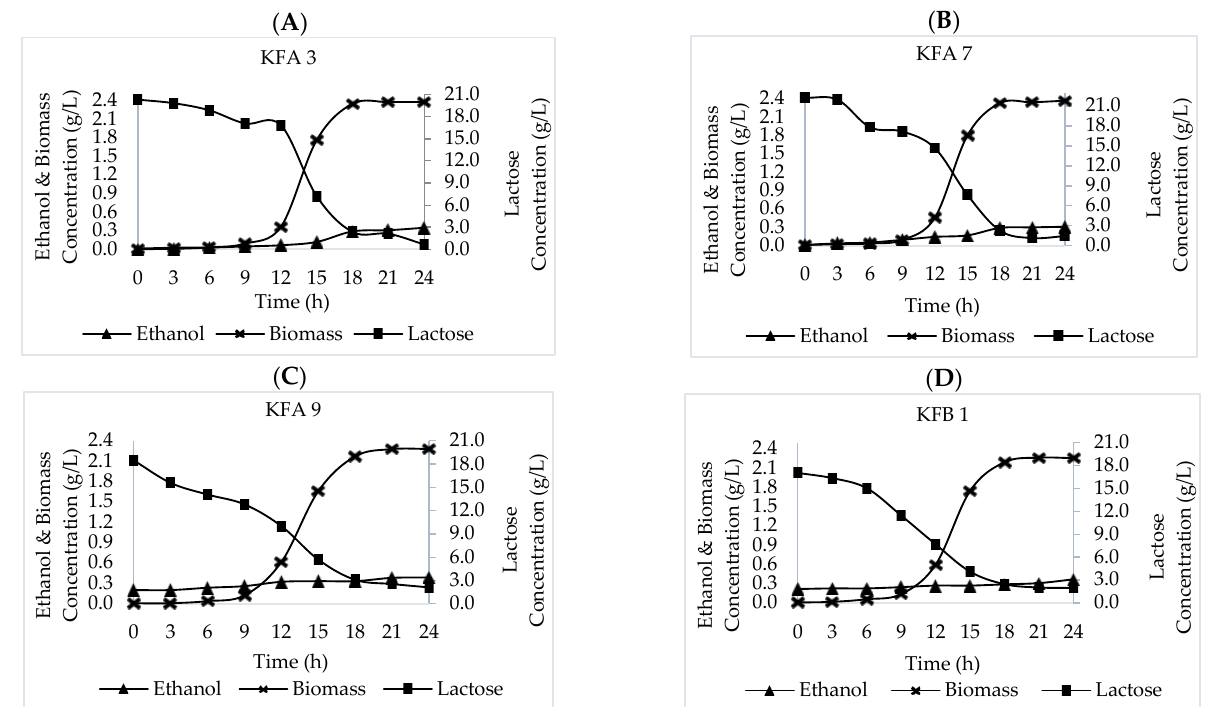
Figure 3. Lactose depletion and biomass and ethanol production of K. marxianus isolates: ( A ) KFA 3, ( B ) KFA 7, ( C ) KFA 9 and ( D ) KFB 1.